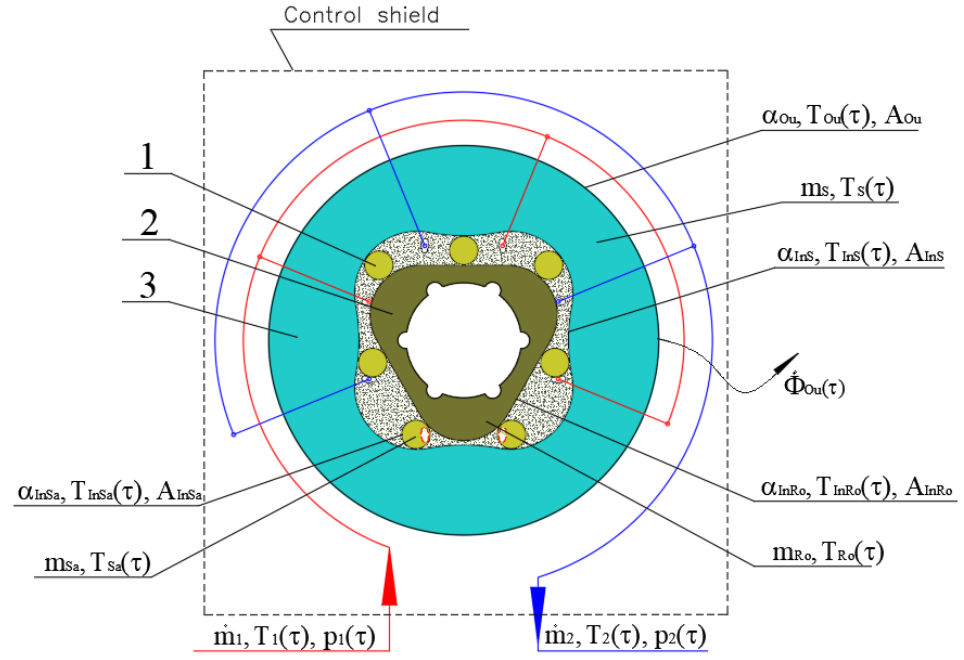
Figure 5. Model of heating of a cooled motor by flowing hot fluid (on the example of a satellite motor); 1—satellite, 2—rotor, 3—fixed elements.